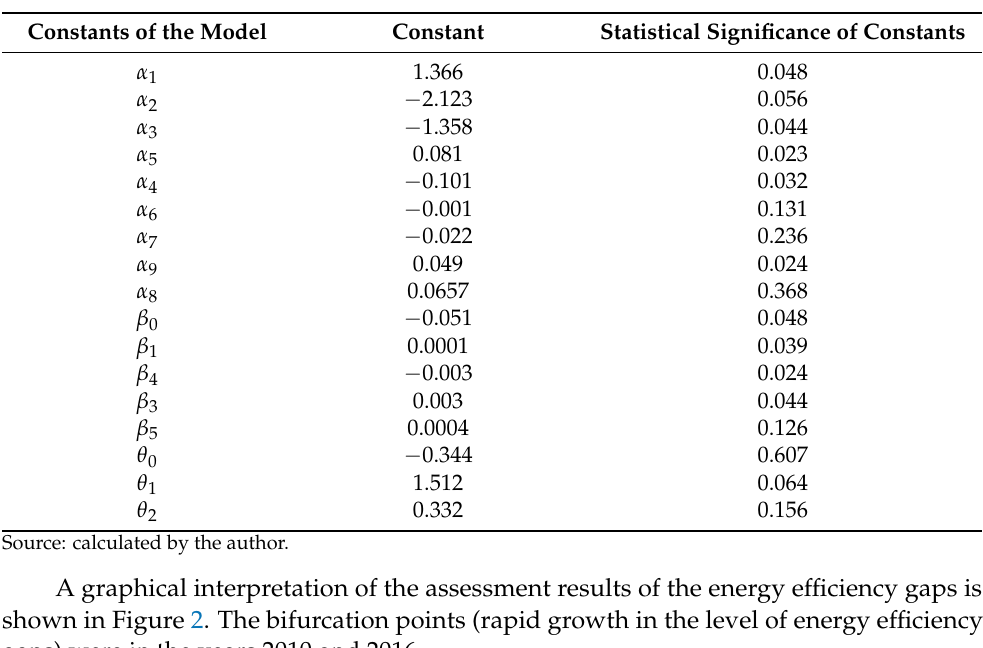
Table 3. The results of the assessment of energy efficiency gaps in the national economy.